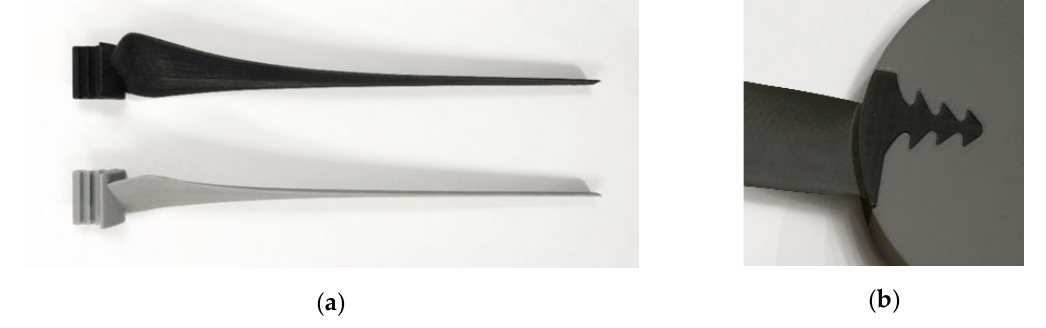
Figure 6. 3D-printed scaled blades ( a ) and altered blade mounting ( b ).